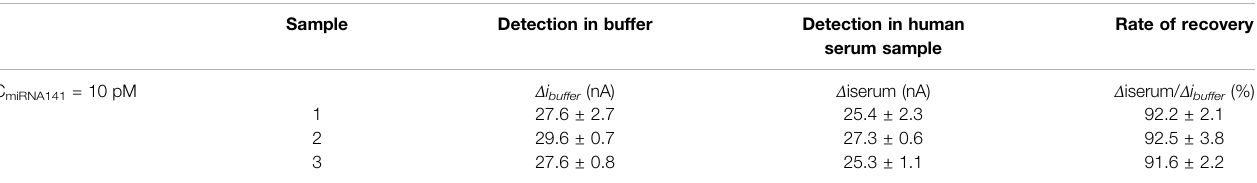
TABLE 3 | The rate of recovery detection of 10 pM miRNA141 in human serum samples. Sample Detection in